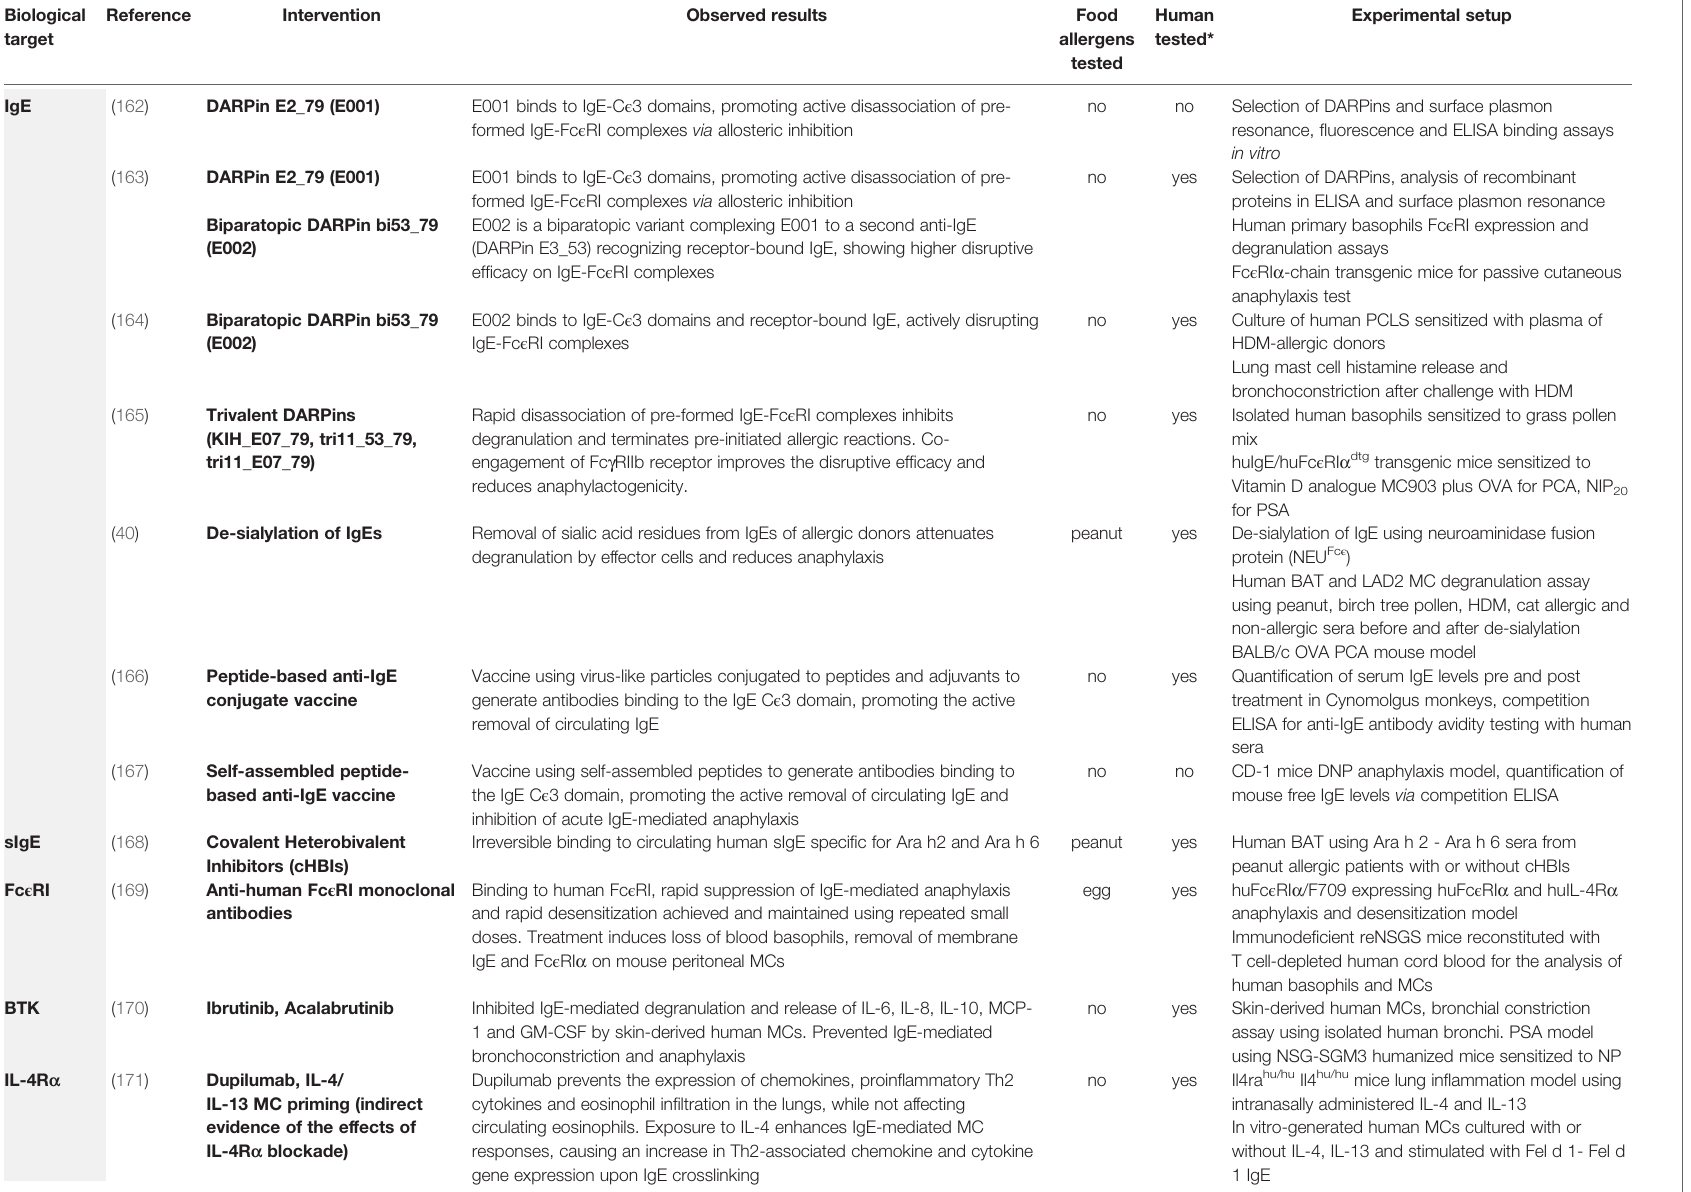
TABLE 3 | Interventions aimed at reducing IgE-mediated mast cell activation currently at pre-clinical/early clinical stage. Biological